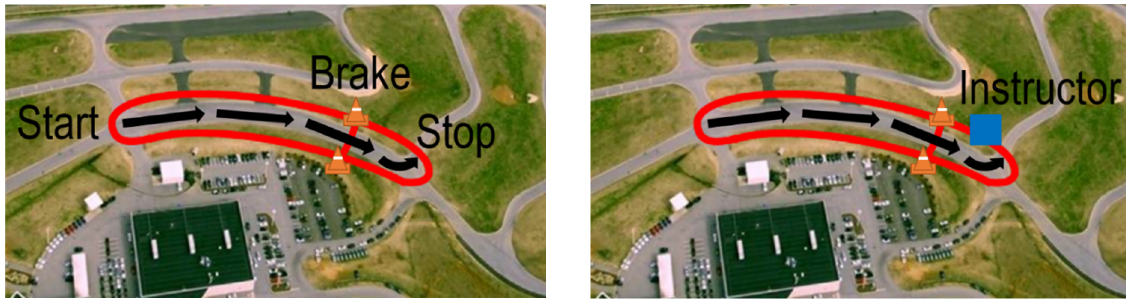
Figure 2. Map of the ABS exercise.